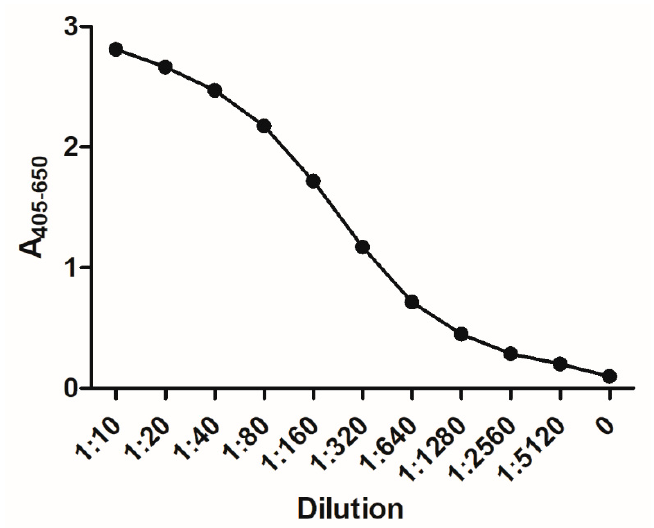
Figure 7. Antibody titration of SSI-HYB 387-01 to glutamic acid decarboxylase (GAD)67 analyzed by enzyme-linked immunosorbent assays.